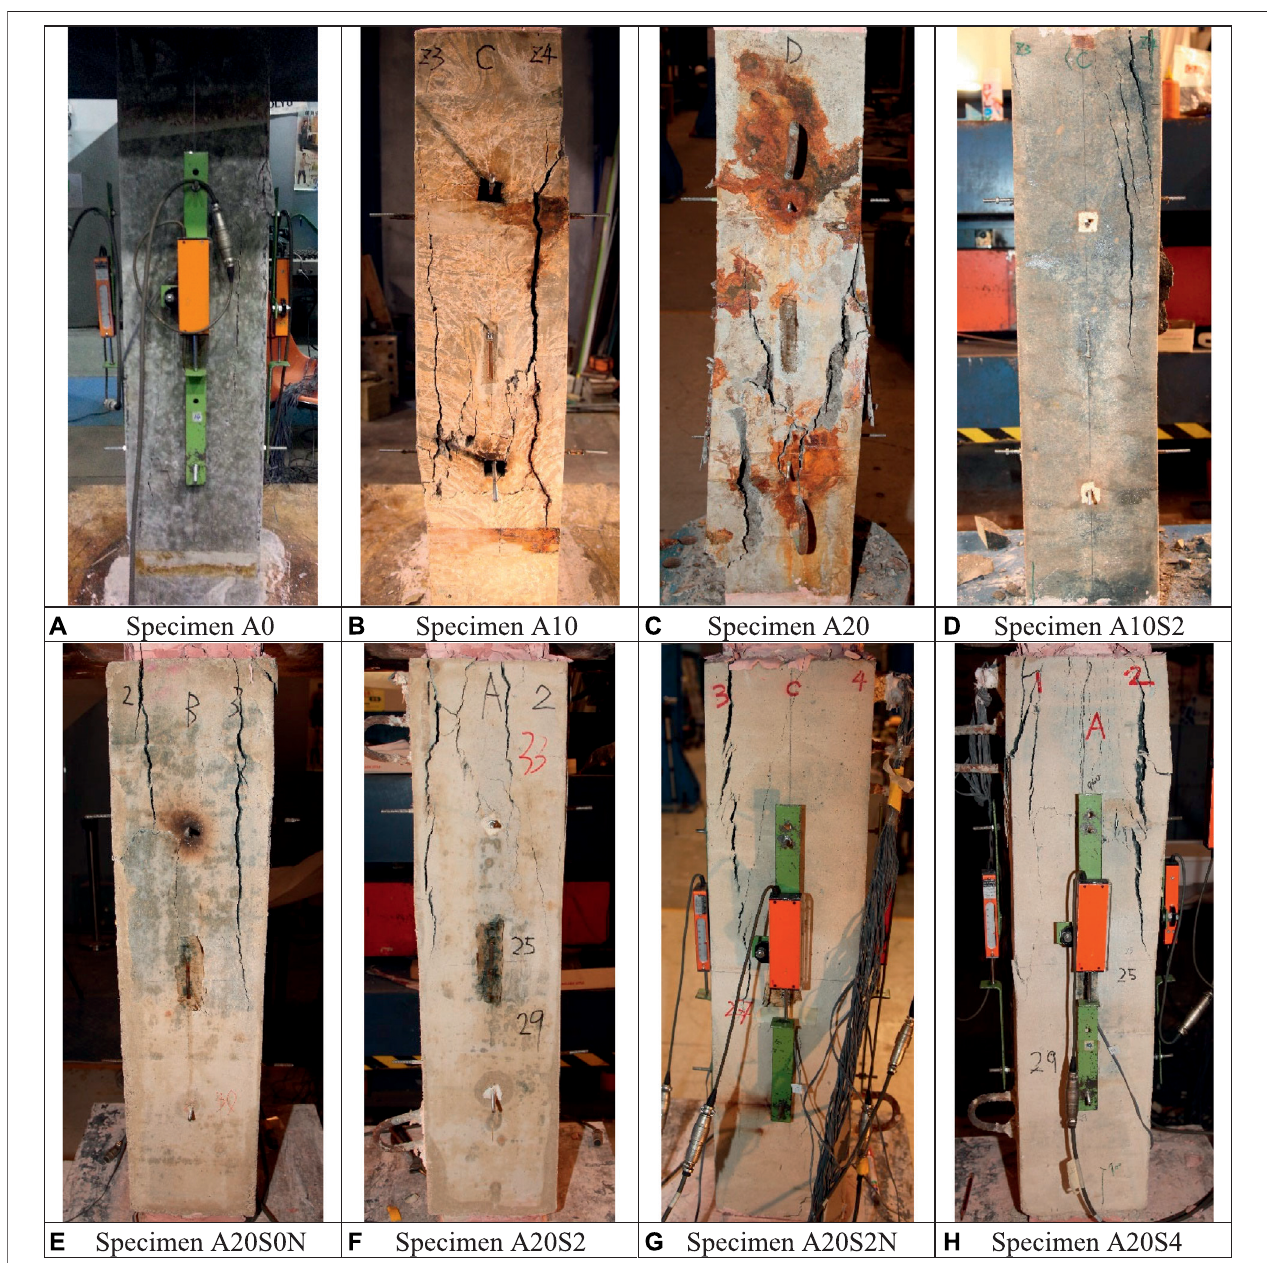
FIGURE 7 | Failure modes of specimens under axial compression. (A) Specimen A0. (B) Specimen A10. (C) Specimen A20. (D) Specimen A10S2. (E) Specimen A20S0N. (F) Specimen A20S2. (G) Specimen A20S2N. (H) Specimen A20S4.